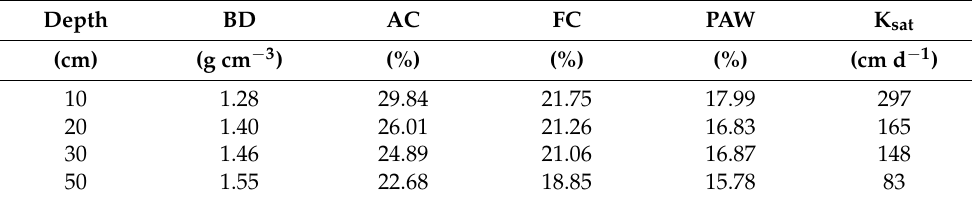
Table 1. Soil hydraulic properties (bulk density (BD, g cm − 3 ), air capacity (AC, %), field capac- ity (FC, %), plant available water content (PAW, %), and saturated hydraulic conductivity (K sat , cm d − 1 )) at 10 cm, 20 cm, 30 cm, and 50 cm depth of the potato ridges according to soil moisture probe measurements. Depth